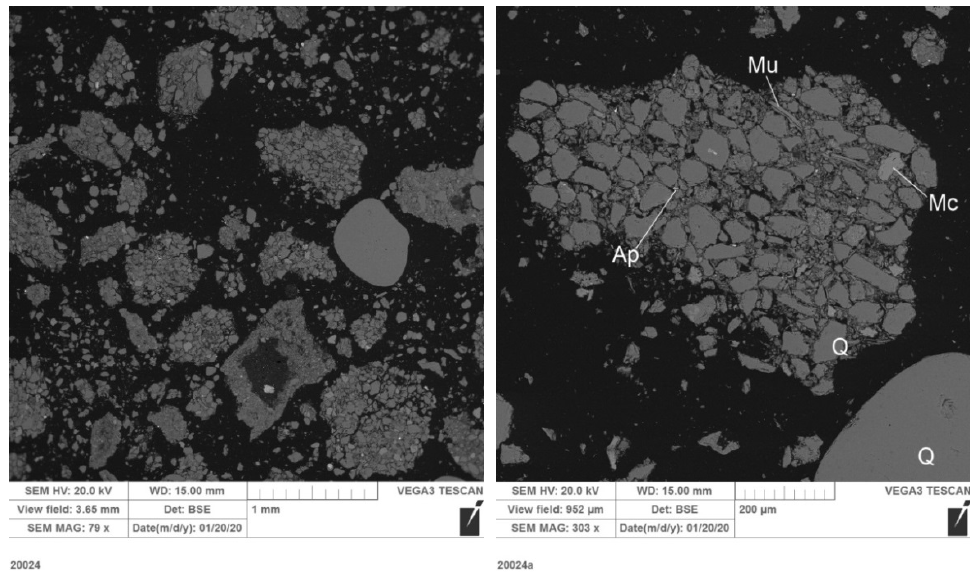
Figure A5. SEM micrograph of Sample GGS2-11-5. Fragments of quartz (Q, large rounded sand grain in the left photo), potassium feldspar (Mc), muscovite with mica cement, and accessories: apatite (Ap). No calcium carbonates were found in the cement. Loss on ignition is probably associated with mica-kaolin cement. Illite is enriched with magnesium.